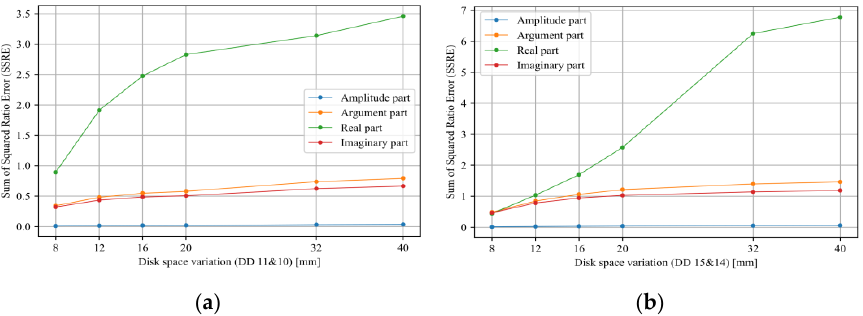
Figure 20. Feature variations based on the severity of the DSV fault in different locations for ex-